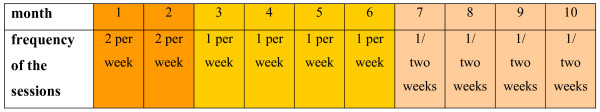
Frequency of therapy sessions in the intervention conditions. It has to be noted that a treatment period of 40 sessions does not equal always 10 months. We therefore defined the measurement point T2 as 10 months after inclusion in the study (± 2 weeks).